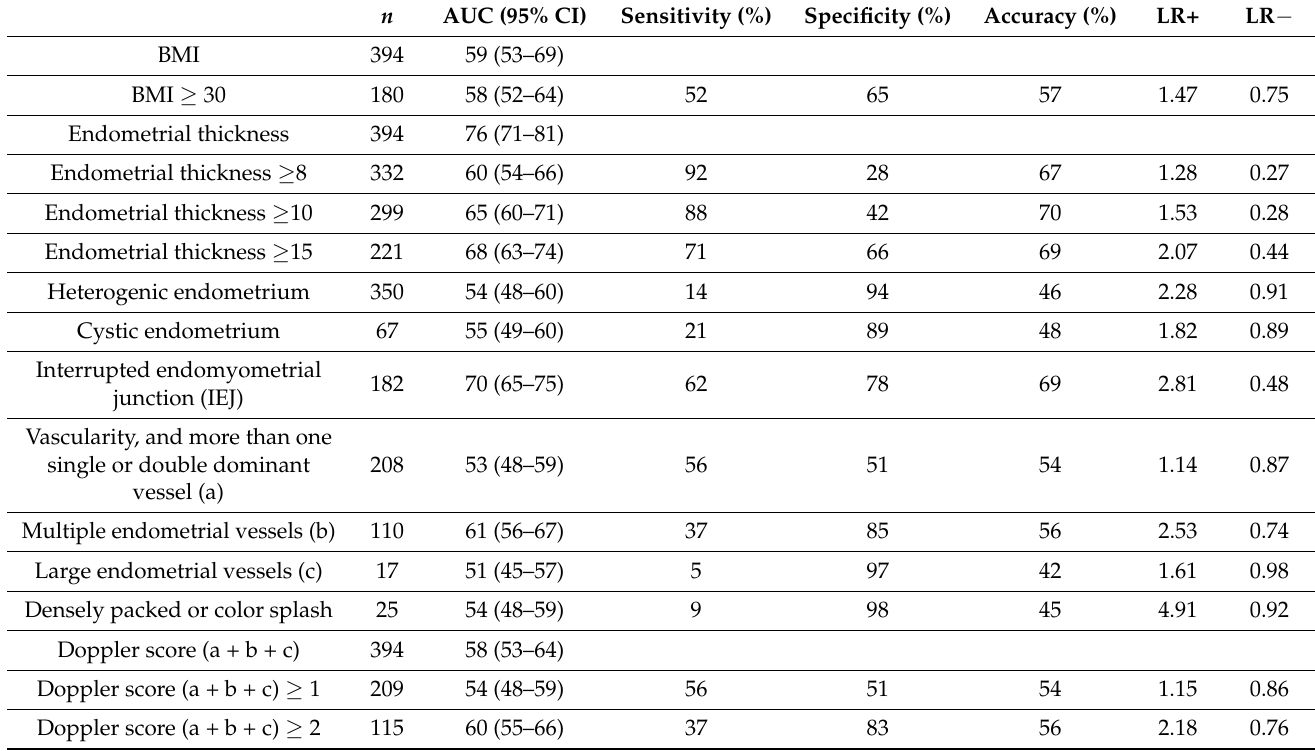
Table 3. Clinical and sonographic parameters used for the prognosis of endometrial cancer or endometrial hyperplasia in validation study (endometrial hyperplasia—EH, body mass index—BMI, transvaginal sonography—TVS, interrupted endomyometrial junction—IEJ, endometrial cancer—EC, atypical hyperplasia—AH, area under curve—AUC).